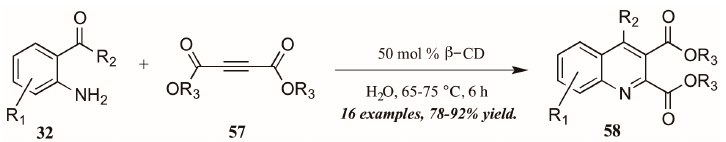
Figure 27. Friedländer quinoline synthesis via biomimetic catalysis.